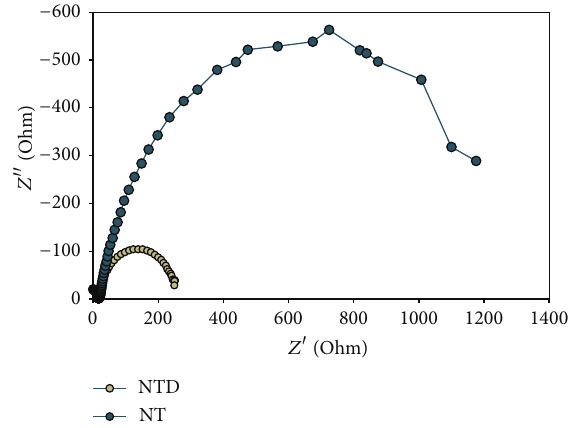
Figure 8: Nyquist plot of EIS recorded at the OCV in 5mM ferro/ferricyanide at pH = 7 with different samples.